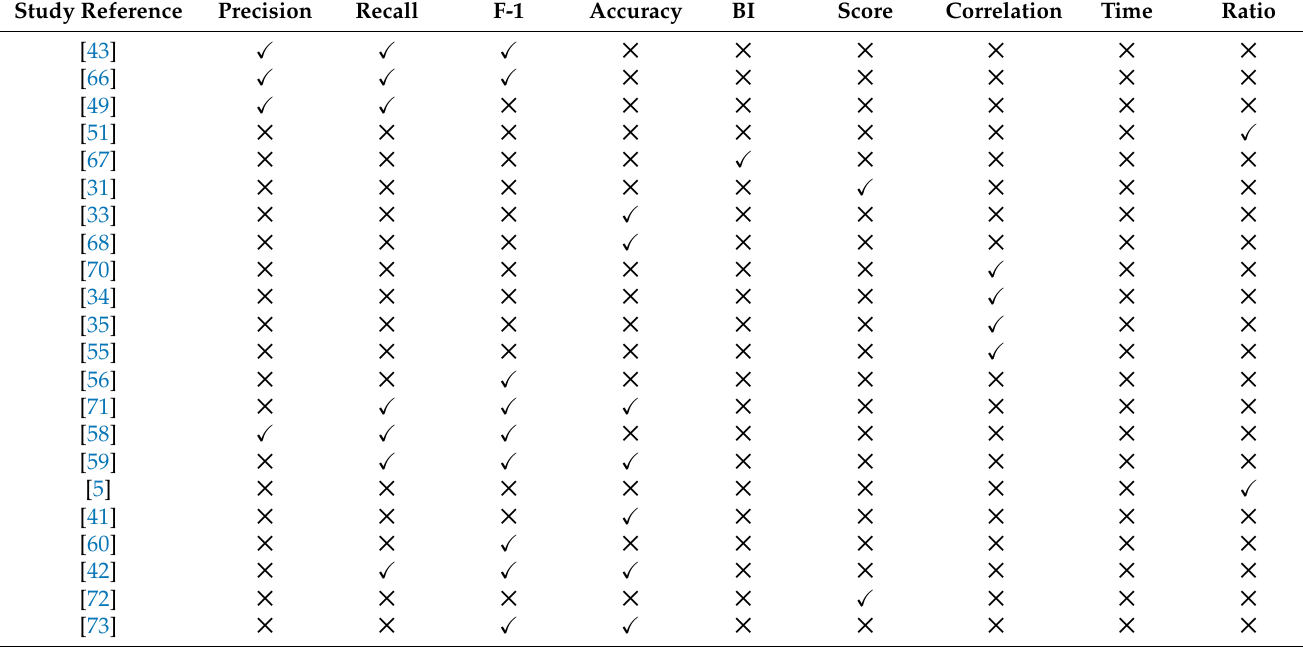
Table 12. Performance measure